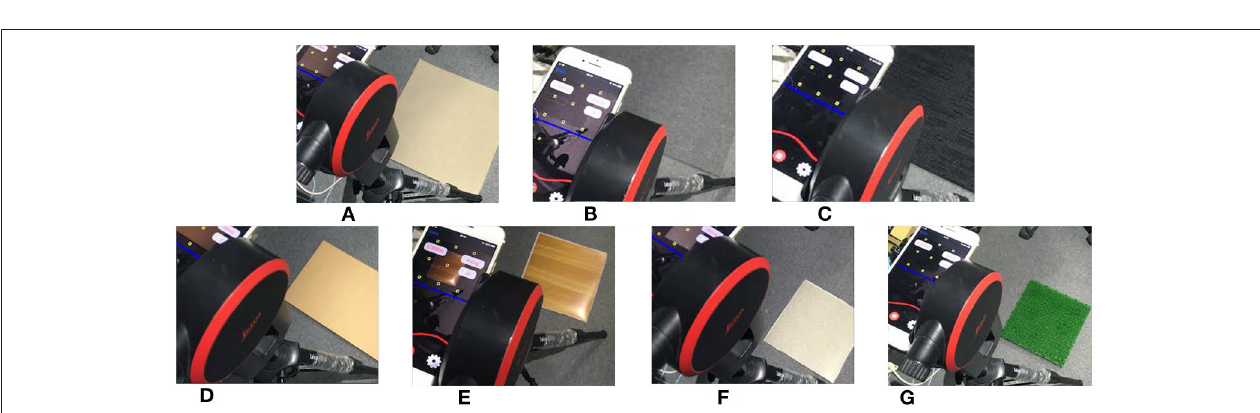
FIGURE 6 | Materials on the floor surface used in the experiment. (A) White mat, (B) gray mat, (C) black mat, (D) non-glow wood, (E) glow wood, (F) marble, and (G) artificial grass.